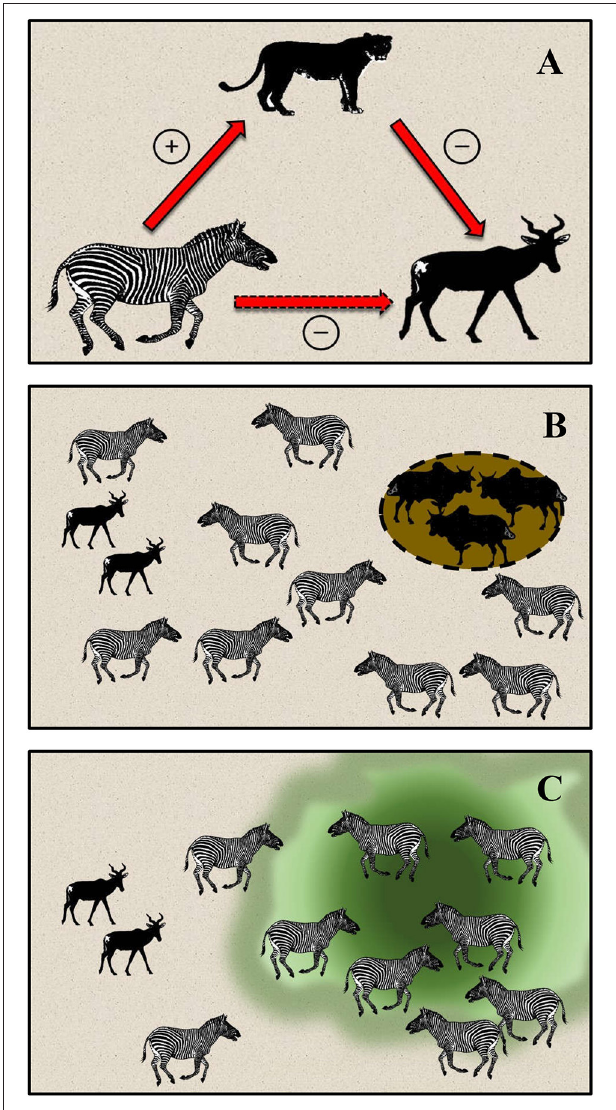
FIGURE 1 | Hypothesized species interactions among lions, plains zebra, Jackson’s hartebeest, and cattle in Laikipia, Kenya. (A) The hypothesis of apparent competition. Zebra populations are controlled bottom-up by rainfall, are the primary prey of lions, and support a growing population of lions since the cessation of lethal control in the late-1980s. Although they are less abundant than zebra, hartebeest are selectively killed by lions and are controlled top-down, such that hartebeest incur negative, indirect impacts from zebra via lions. (B) Cattle are corralled overnight in bomas where they deposit dung and urine for a period of ca. 1 month. (C) After abandonment, dung and urine break down over the course of 2–3 years, creating nutrient-rich forage in glades where zebra aggregate, but not hartebeest. This creates spatial separation between zebra and hartebeest, and potentially a refuge from predation if lions target hunting activity toward areas where zebra are